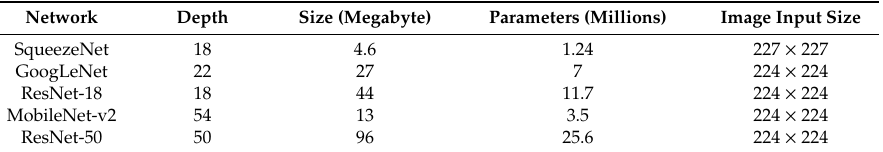
Figure 2. Relative speeds and accuracies of the different networks used in this study. Black dash line represents for Pareto frontier: data from Benchmark Analysis of Representative Deep Neural Network Architectures [30]. Table 2. Properties of pre-trained networks.